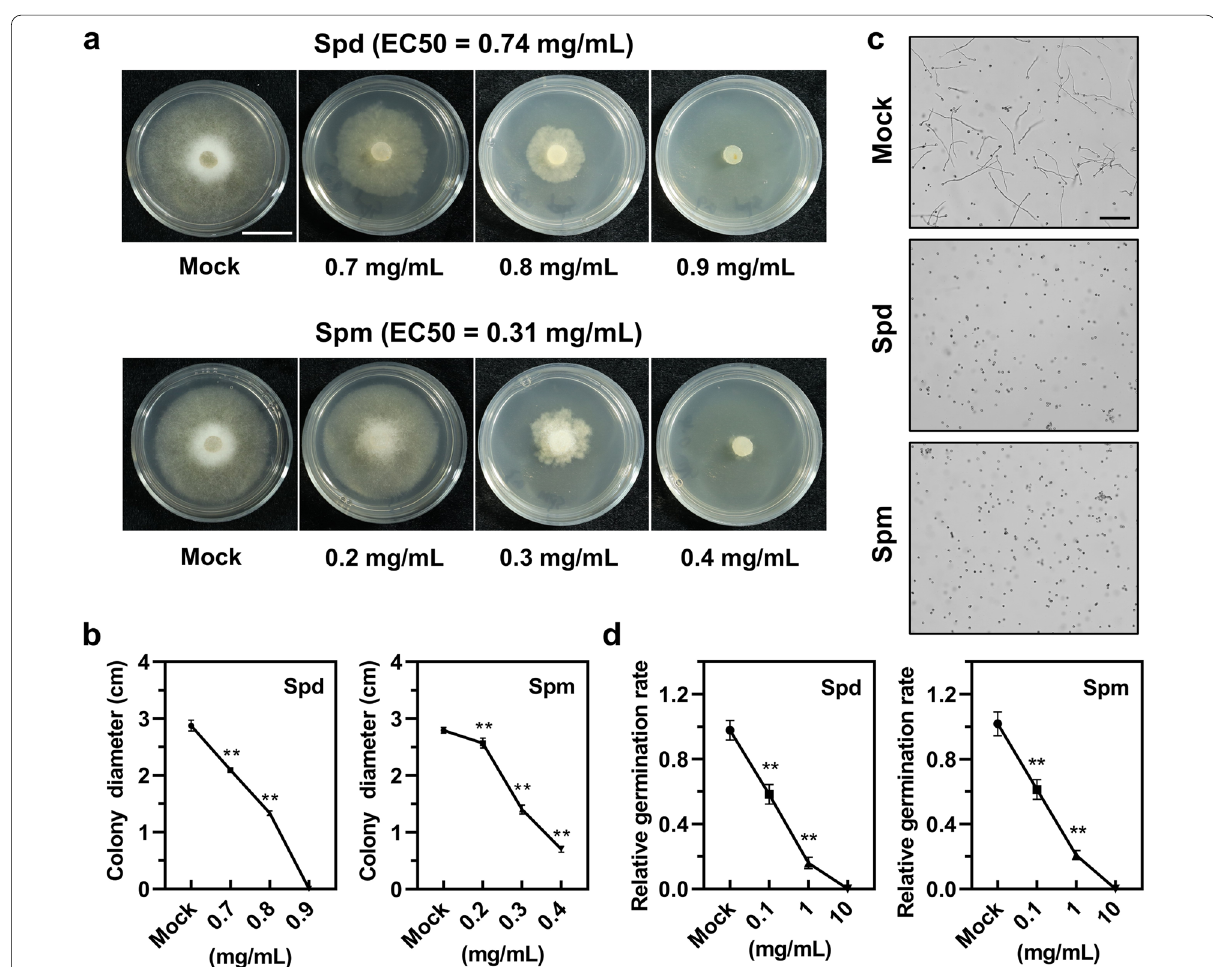
Fig. 4 Effects of PAs (Spd and Spm) on colony growth and zoospore germination of P. sojae . a Inhibition of P. sojae hyphal growth by Spd or Spm. Mock represents treatment with ddH 2 O. Scale bar, 1 cm. c Inhibition of P. sojae zoospore germination by Spd (1 mg/mL) or Spm (1 mg/mL). Mock represents treatment with